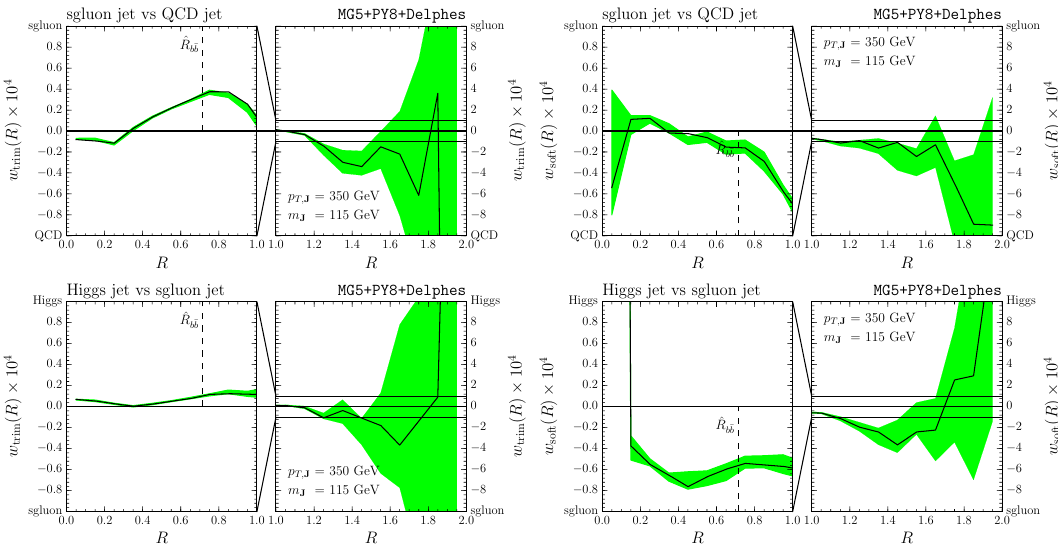
Figure 15 . The weights w trim (left) and w soft (right) at p T; J = 350 GeV and m J = 115 GeV for the sgluon jet vs. QCD jet (top) and the Higgs jet vs. sgluon jet (bottom) classi(cid:12)cation. We show the weights with statistical uncertainty from the training